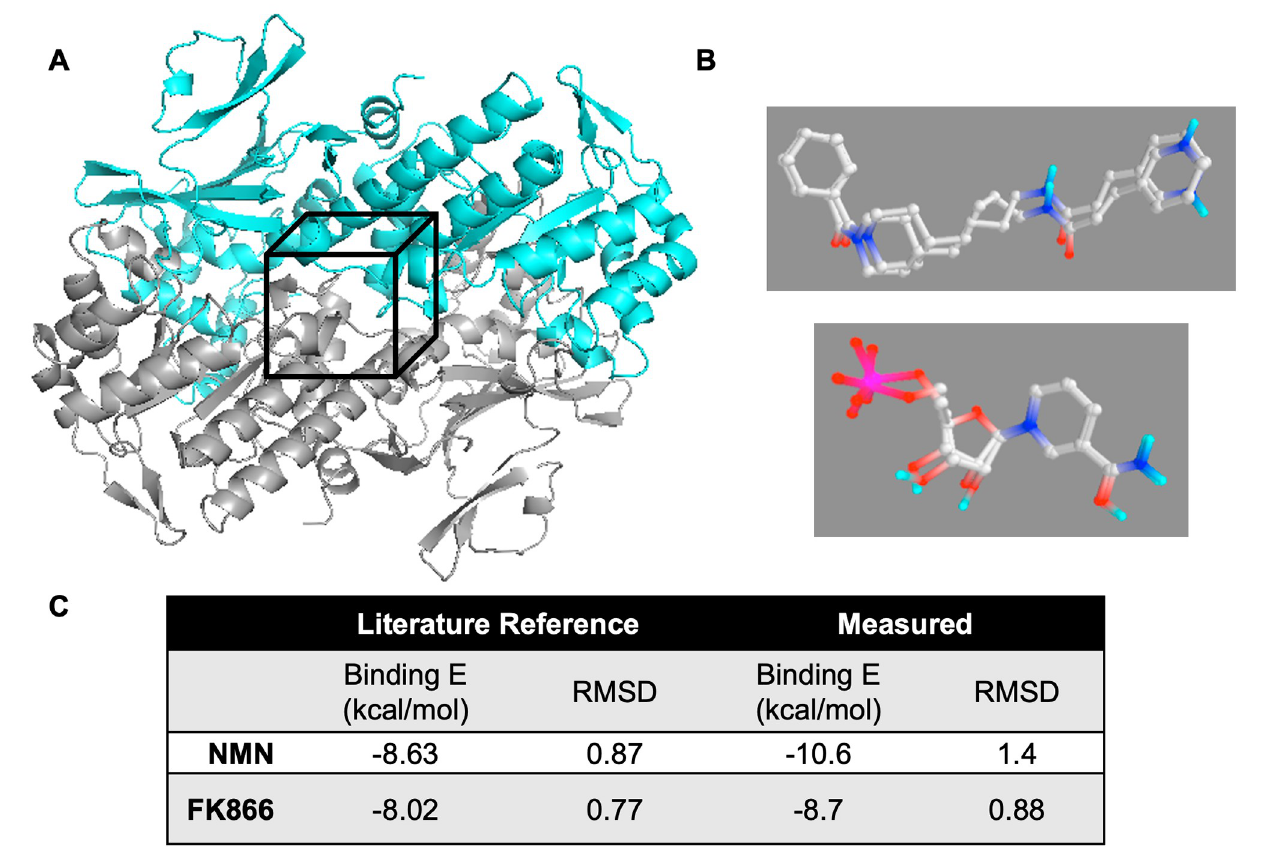
Fig 2. Validation of Autodock Vina screening of NCI diversity set III. (A) Ribbon image of NAMPT dimer (PDB ID: 2GVG) Black box indicates search space centered around K389 residue. (B) Overlays of Autodock redocking compared to interactions reported in 2GVG molecule. Top panel shows known inhibitor FK866. NAMPT product NMN shown in bottom panel. (C) Table comparing Binding Energy and Root Mean Square Deviation (RMSD) reported in literature to Autodock measured parameters.